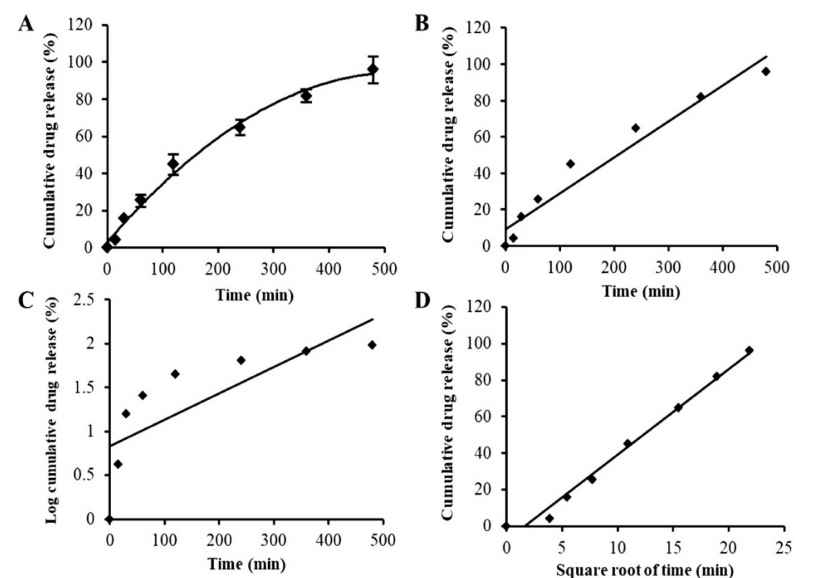
Figure 5. In vitro drug release profile of APC-SNEDDS ( A ) and drug release kinetics plots using various kinetic models: zero-order kinetics (r 2 = 0.9513) ( B ), first-order kinetics (r 2 = 0.6008) ( C ), and Higuchi model (r 2 = 0.9875) ( D ).